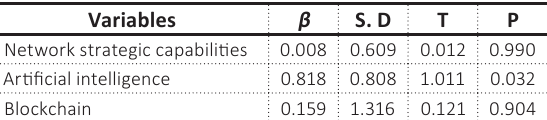
Table 8. Path analysis to employ networks strategic capabilities on infrastructure